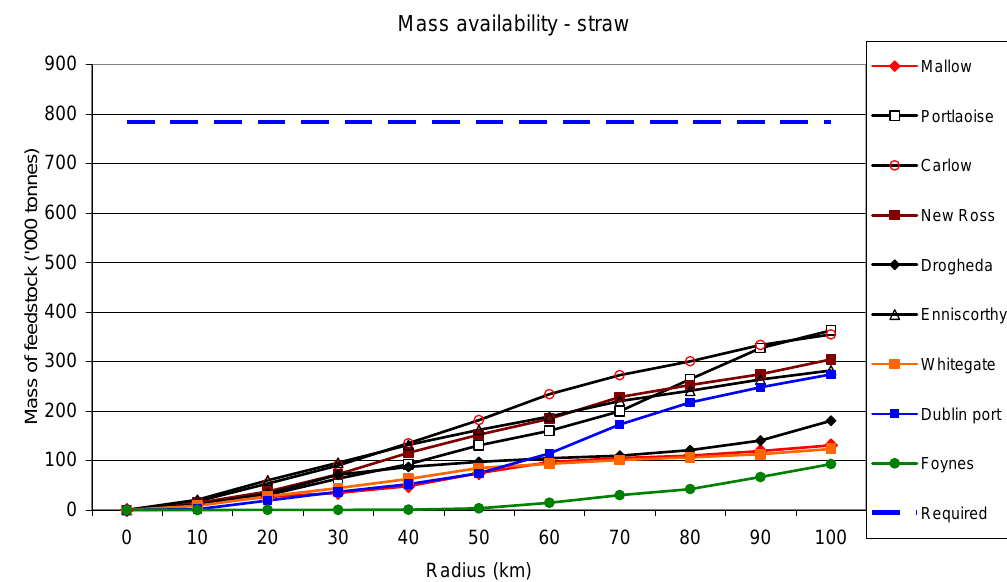
Figure 6. Modeled availability of straw around each